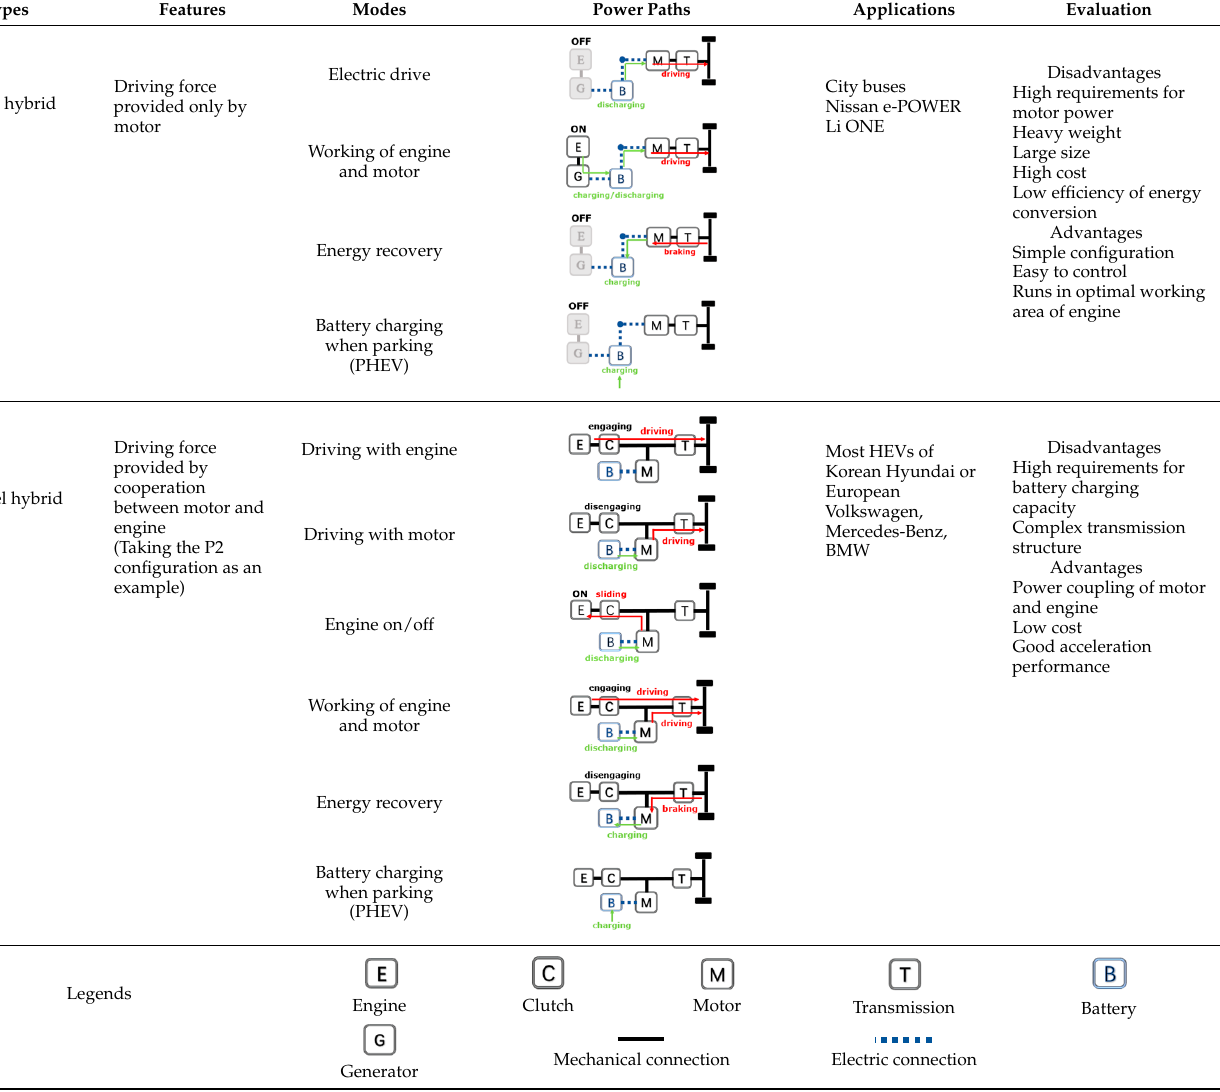
Table 1. Series hybrid and parallel hybrid powertrain configurations [6,10].